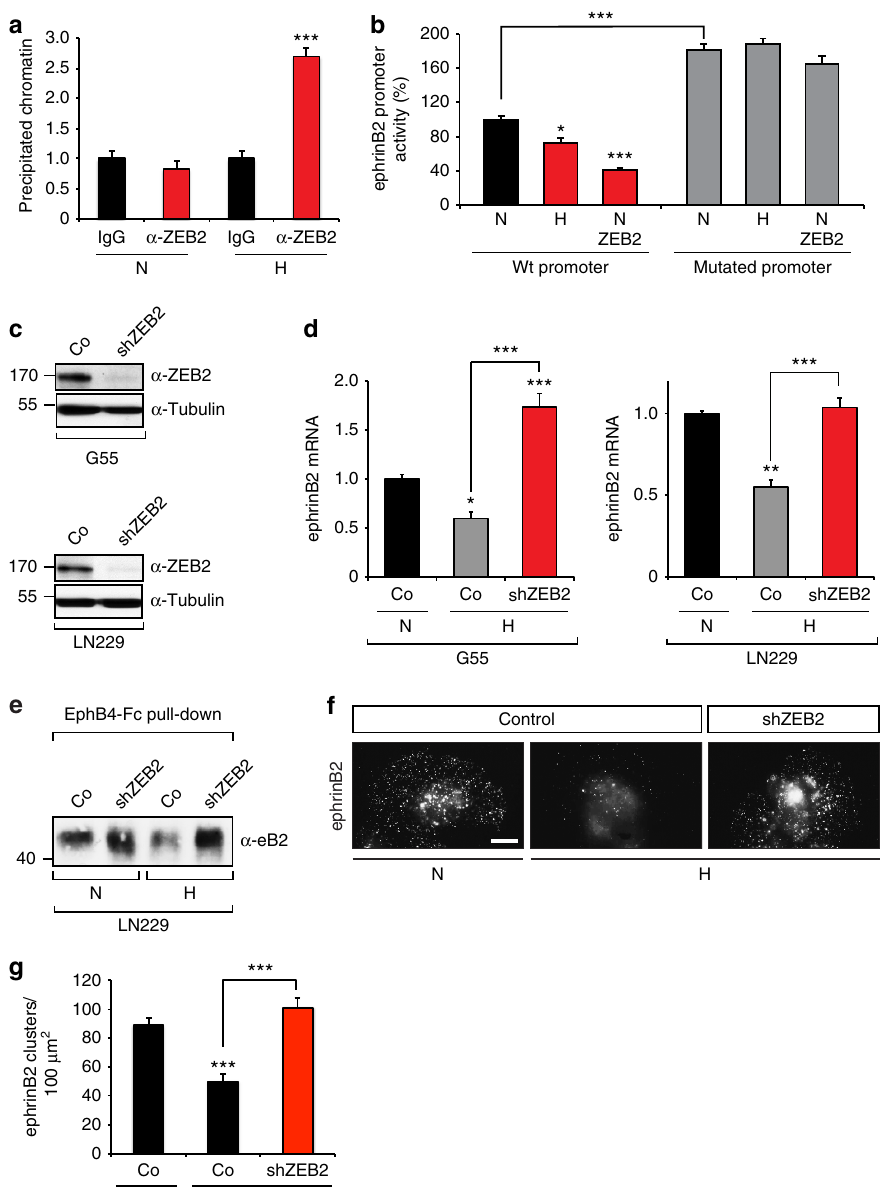
Figure 4 | The hypoxia-induced ephrinB2 repression is mediated by ZEB2. ( a ) ZEB2 binds to the ephrinB2 promoter. qRT–PCR quantification of relative chromatin amount precipitated with anti-ZEB2 antibody compared with IgG control at 21% O 2 (N) or 1% O 2 (H) ( n ¼ 5–6). ( b ) ZEB2 represses the ephrinB2 promoter activity.G55 glioblastoma cells were transfected with different murine ephrinB2 promoter constructs (containing wild-type (WT) and mutated ZEB2-binding sites), ZEB2 expression construct and exposed to 21% O 2 (N) or 1% O 2 (H) for 18h. EphrinB2 promoter activity was determined by a luciferase reporter assay ( n ¼ 3). ( c , d ) ZEB2 is required for the hypoxia-mediated repression of ephrinB2 mRNA levels. Immunoblot of G55 and LN229 glioblastoma cells stably transduced with scrambled control or ZEB2 shRNA, probed for ZEB2 ( c ). qRT–PCR analysis of ephrinB2 mRNA levels in G55 and LN229 glioblastoma cells expressing scrambled control or ZEB2 shRNA following exposure to 21% O 2 (N) or 1% O 2 (H) for 18h ( n ¼ 3) ( d ). ( e – g ) ZEB2 is required for the hypoxia-mediated downregulation of ephrinB2 protein. Immunoblot of LN229 glioblastoma cells stably transduced with scrambled control or ZEB2 shRNA at 21% O 2 (N) or 1% O 2 (H) for 18h following pulldown of ephrinB2 by EphB4-Fc ( e ). EphrinB2 clusters detected by EphB4-Fc immunofluorescence in G55 glioblastoma cells stably transduced with scrambled control or ZEB2 shRNA, exposed to 21% O 2 (N) or 1% O 2 (H) for 18h ( f